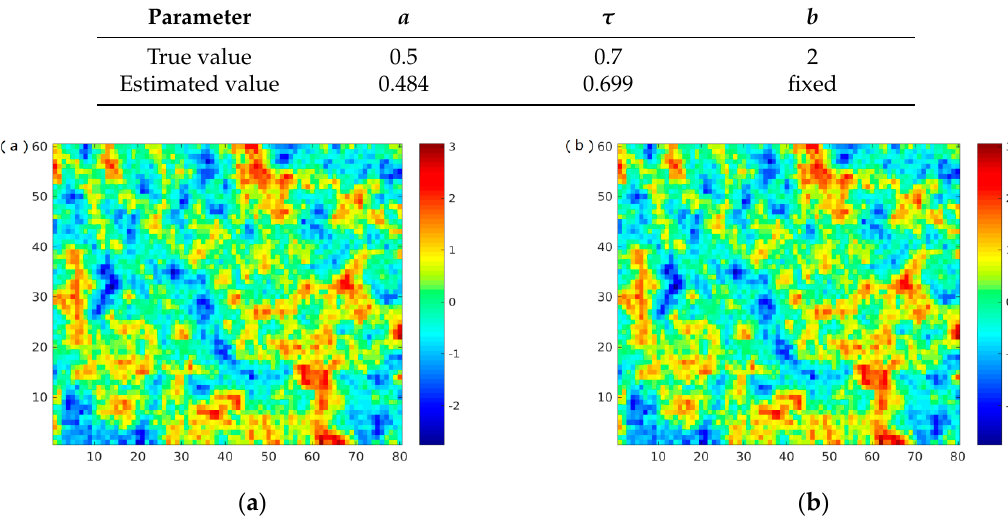
Table 1. The results of the parameters from the synthetic data.